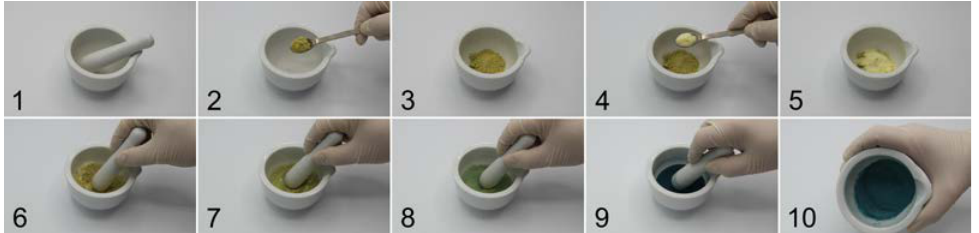
Figure 5. Mechanochemical preparation of Prussian blue from ferrous sulfate and potassium hexa- cyanoferrate(II).